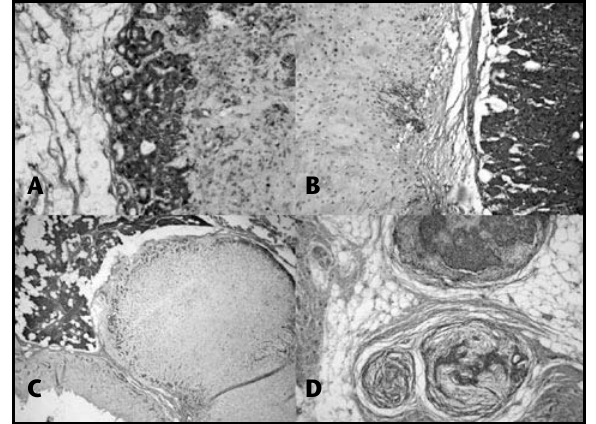
Figura 1 – A: Cápsula incompleta (HE, 100x); B: cápsula delgada (HE, 100x); C: Protrusões para a cápsula (HE, 25x); D: Padrão de recidiva (HE, 100x)